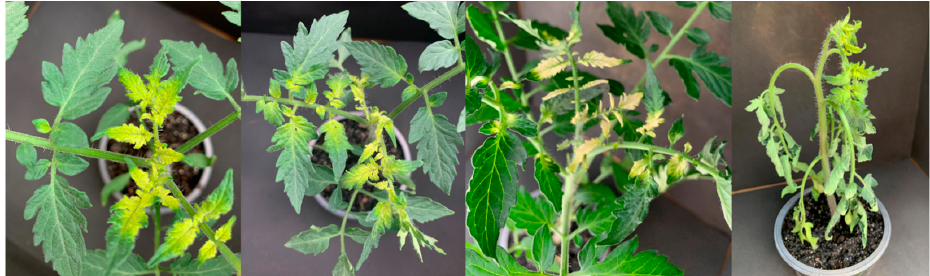
Figure 6. The effects of simulated glyphosate drift with a close-up view show injuries in tomato plants.